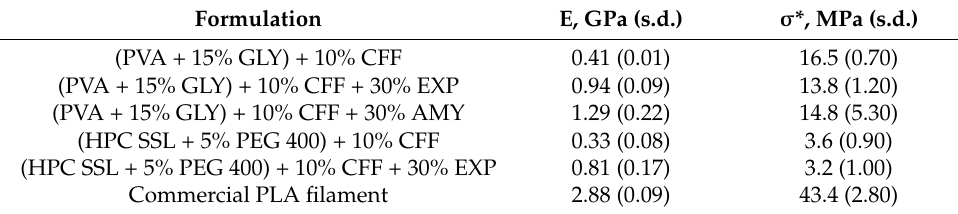
Table 4. E and σ * of filaments produced by HME and of commercially available PLA filament.